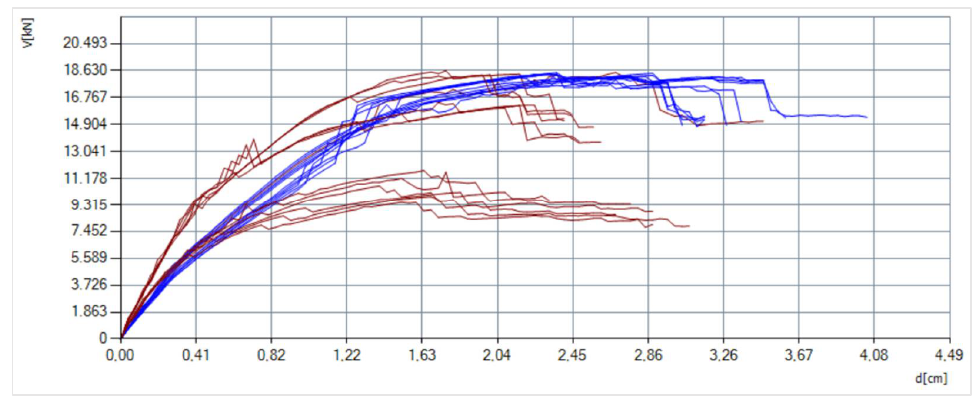
Figure 22. Configuration of shotcrete reinforcement (yellow color): ( a ) on the ground floor; ( b ) on the first floor.